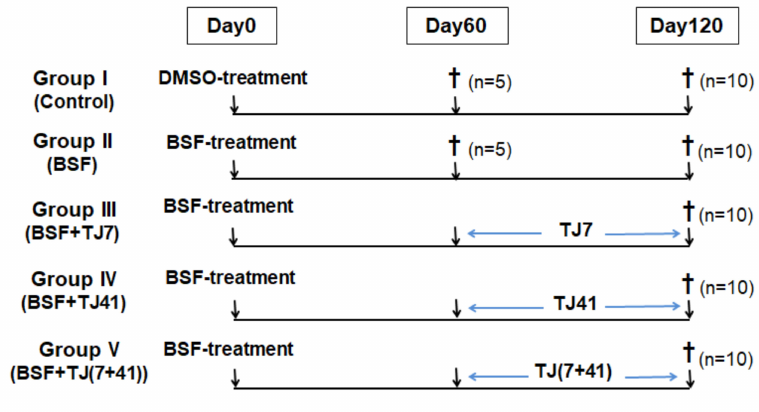
Figure 6. Time schedule of treatment for the mice in each